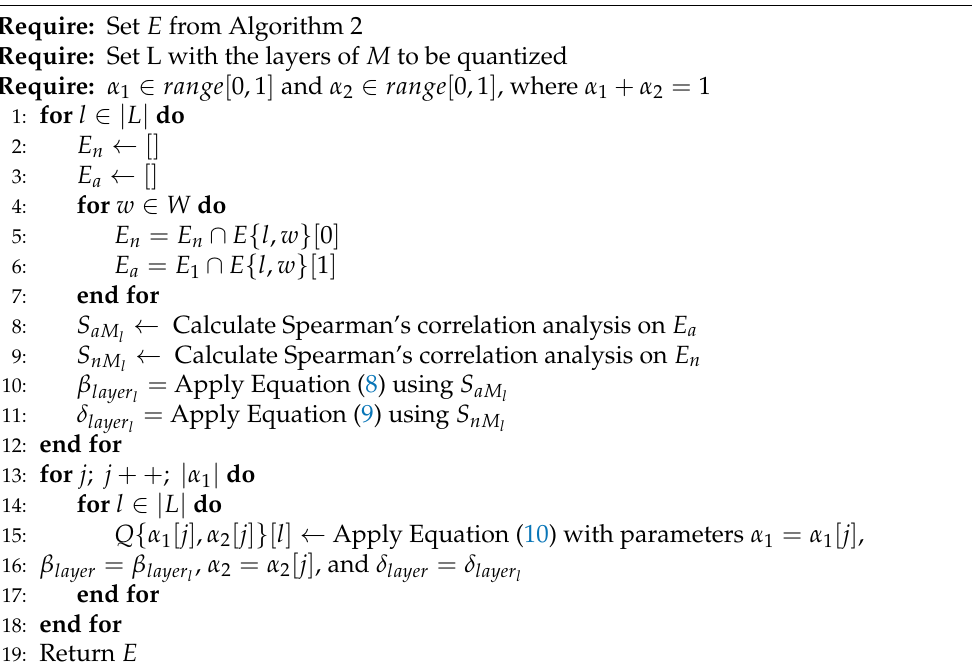
Algorithm 3 Stage 3 and 4: Layered Discriminated Quantization